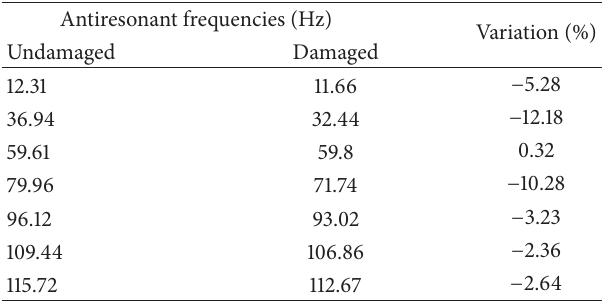
Table 1: Experimental antiresonances.